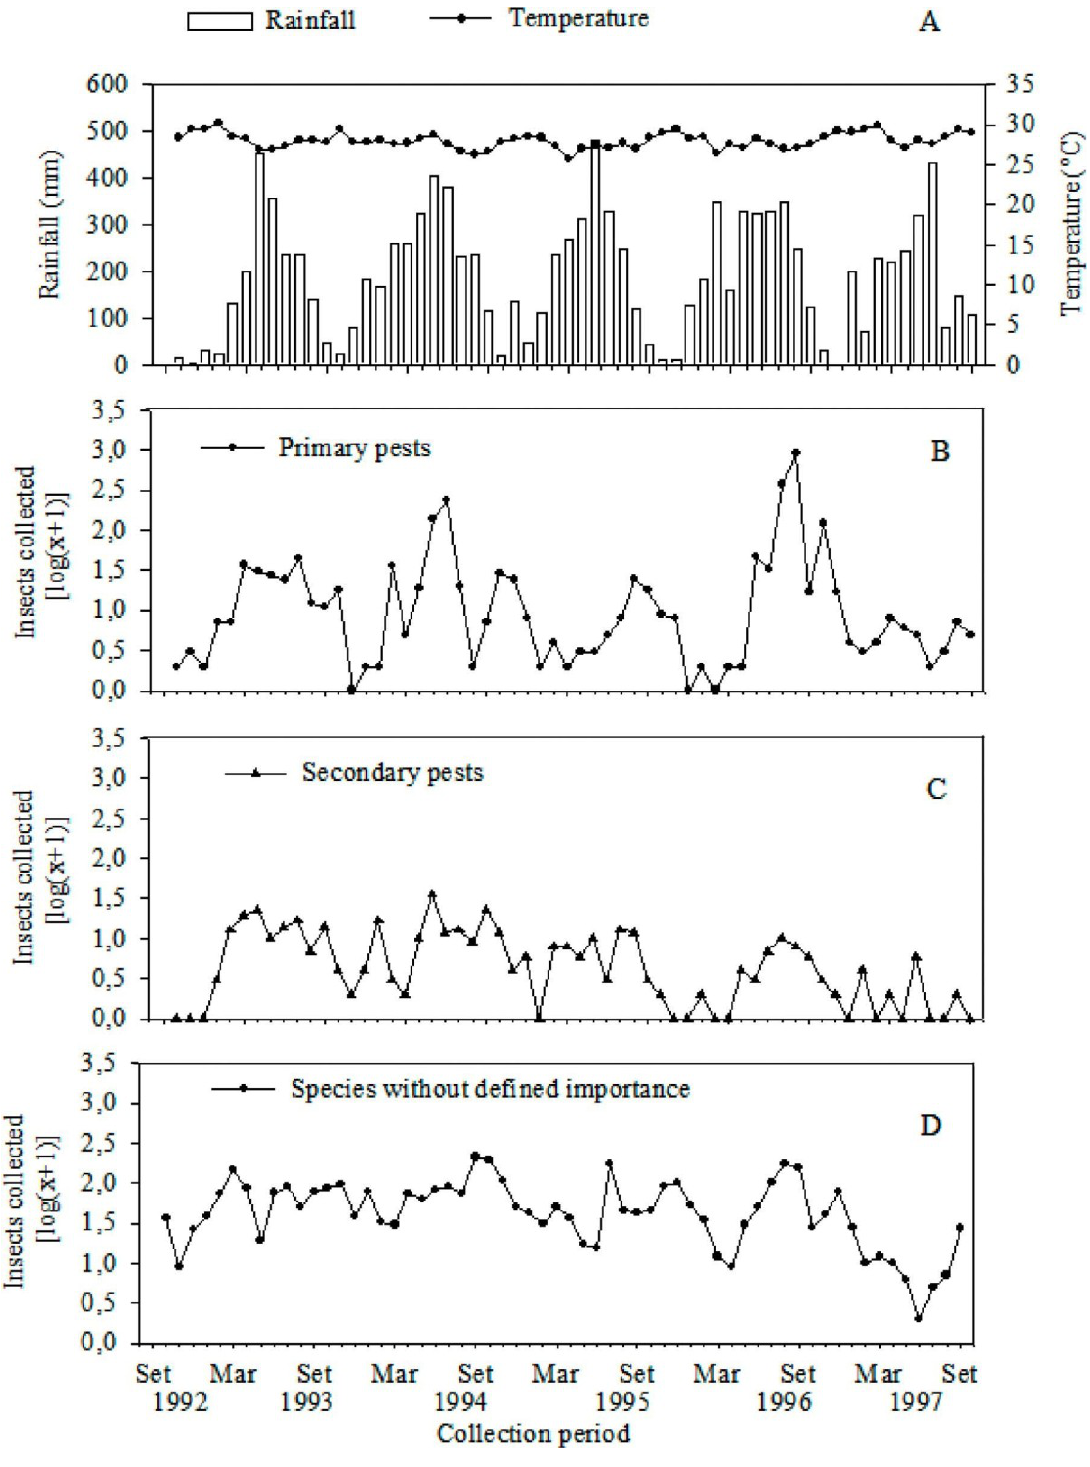
Figure 5. Rainfall (mm), temperature (°C) ( A ), population dynamics of primary pests ( B ), secondary pests ( C ), and species with no defined importance to eucalypts ( D ) in Felipe, Amapá State,